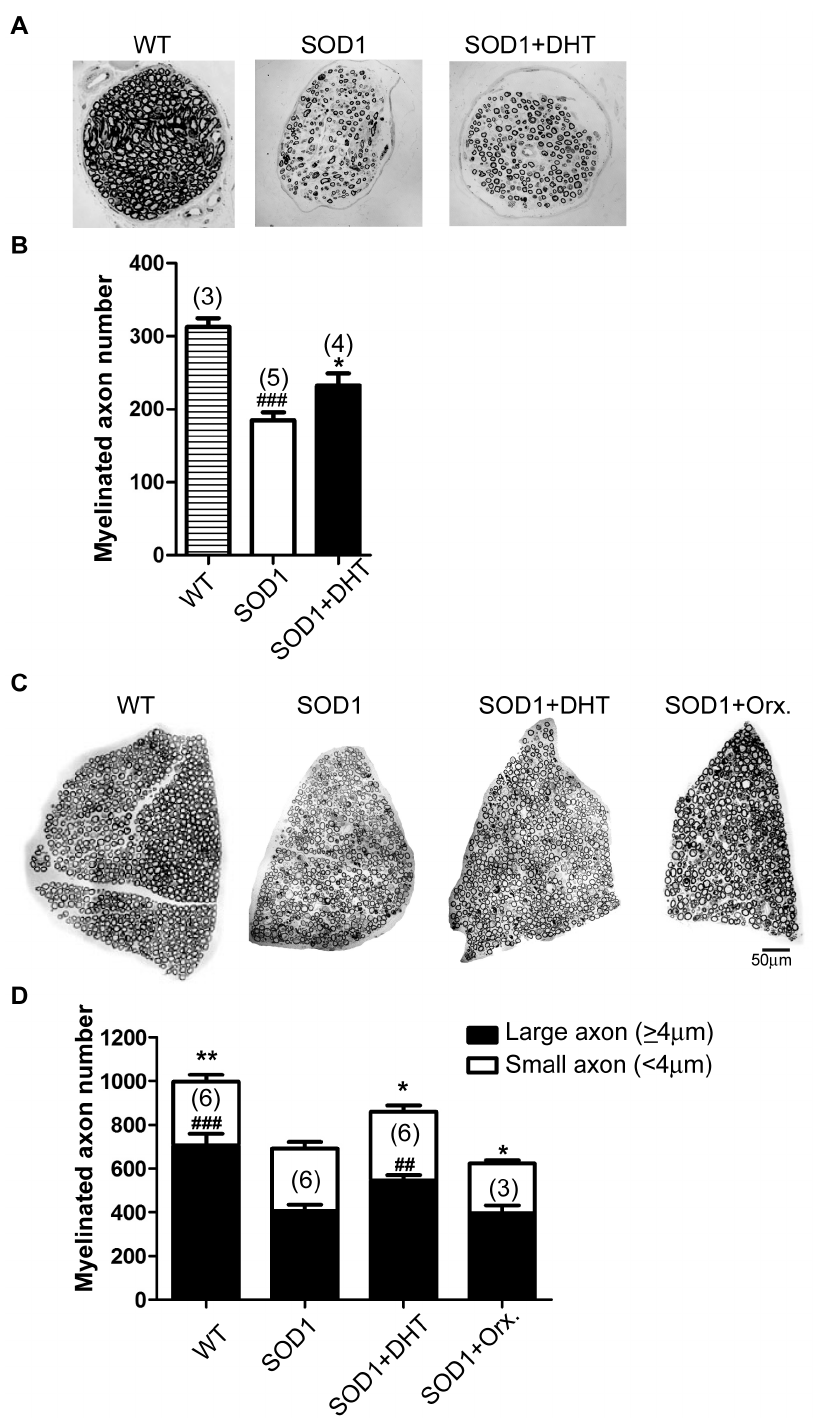
Figure 6. DHT attenuates axonal loss in the phrenic nerve and ventral root of the spinal cord. A: The phrenic nerve at the entry of the diaphragm muscle was sectioned to observe myelinated axons at P120. Representative pictures of the phrenic nerve from WT, control SOD1, and DHT-treated SOD1 mice are shown. B: Quantification of myelinated axon number in the phrenic nerves is shown. The number of myelinated axons in the phrenic nerve of SOD1 mice (184.6 6 10.9) is about 40% less compared with WT mice (313.0 6 11.5, p =0.0003). DHT-treated SOD1 mice showed 26% more myelinated axons (232.3 6 16.8, p =0.043) compared with control SOD1 mice. Sample size is indicated in ( ) for each group. * p , 0.05 (compared with control SOD1 mice), ### p , 0.001 (compared with WT mice). C: Representative cross-sectional pictures of the ventral roots of the spinal cord lumbar 4 segment from WT, control SOD1, DHT-treated SOD1, and orchidectomized SOD1 mice at P120 are shown. D: Quantification of myelinated axon number in the ventral root of the lumbar 4 spinal cord is shown. The total number of myelinated axons in control SOD1 mice (691.2 6 43.6) is about 30% less compared with that in WT mice (996.5 6 58.5, p =0.0012). DHT-treated SOD1 showed 24% more total myelinated axon number compared with control SOD1 mice (859.6 6 53.4, p =0.013). Especially, the number of the large caliber axons ( $ 4 m m) were 43% less in SOD1